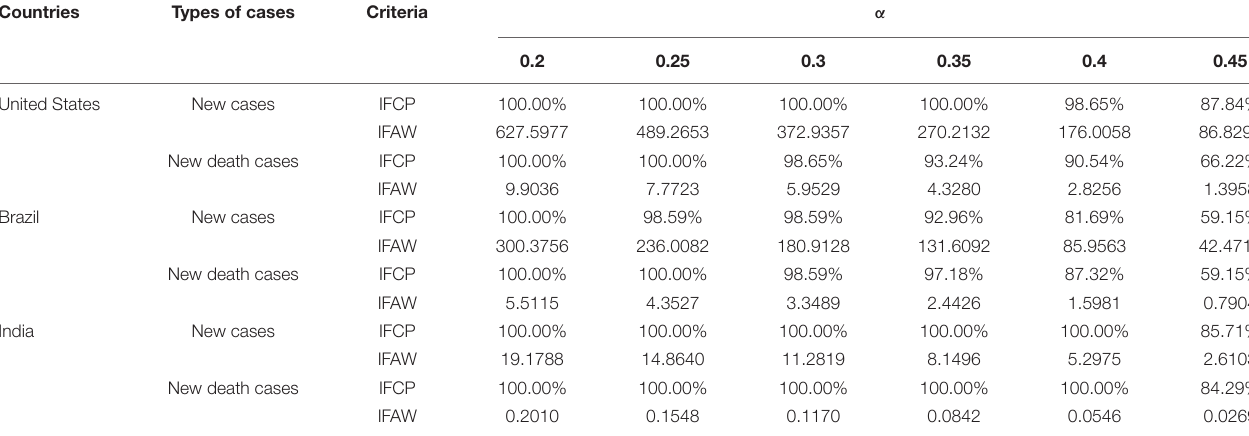
FIGURE 3 | Forecasting results of the proposed model and benchmark models. TABLE 7 | The interval prediction results under five different significance levels of COVID-19 cases.